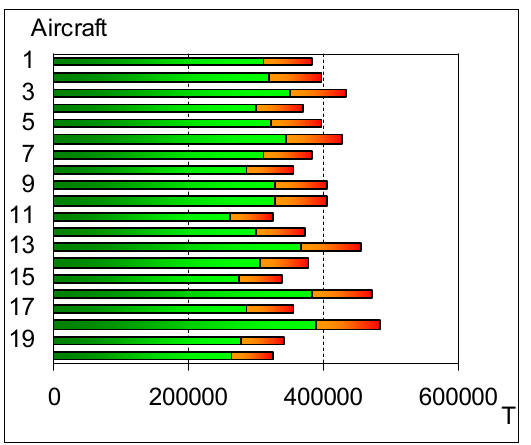
Fig 8. Bar chart of CUCDTP for the non-corroded